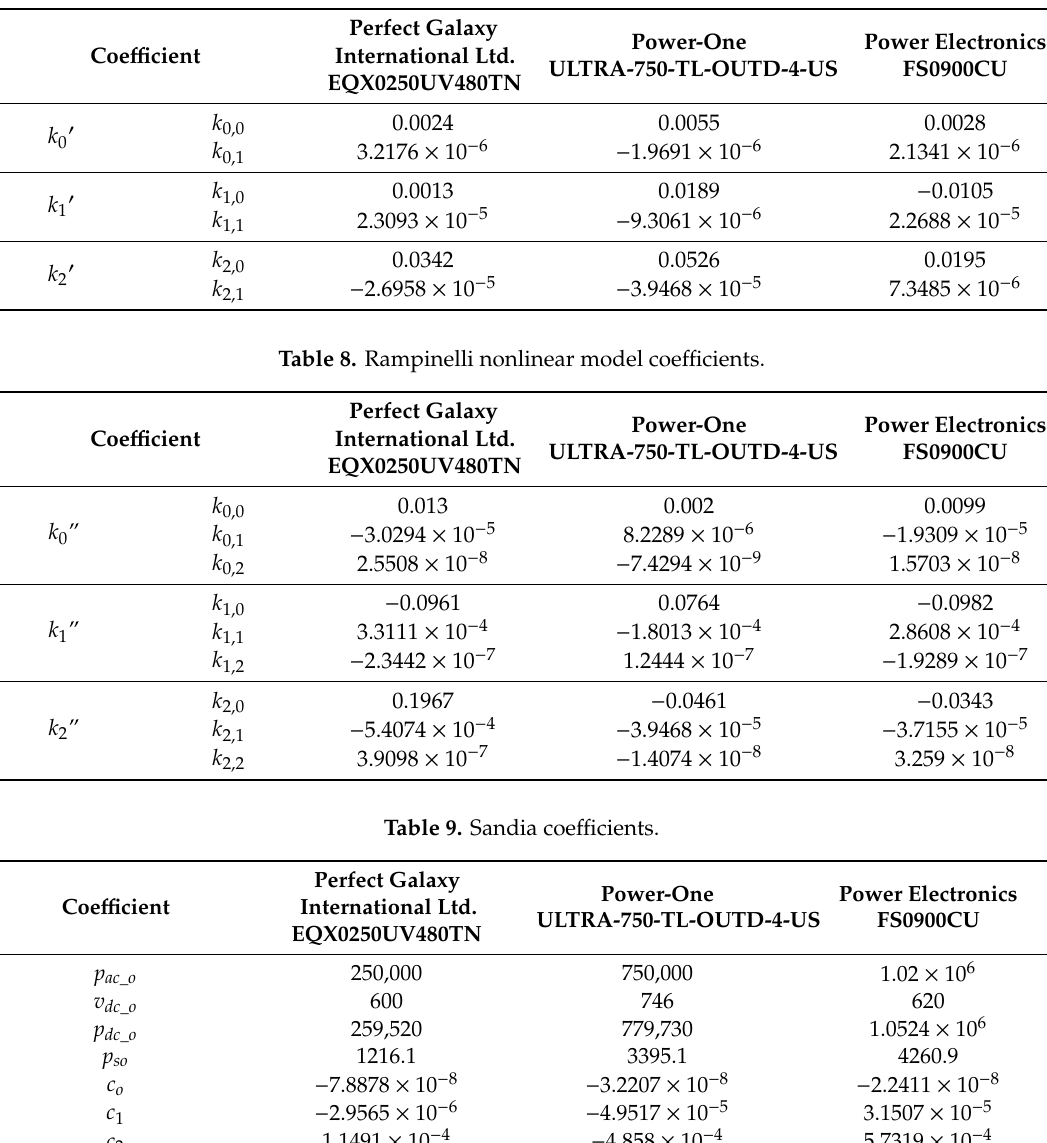
Table 7. Rampinelli coe ffi cients.